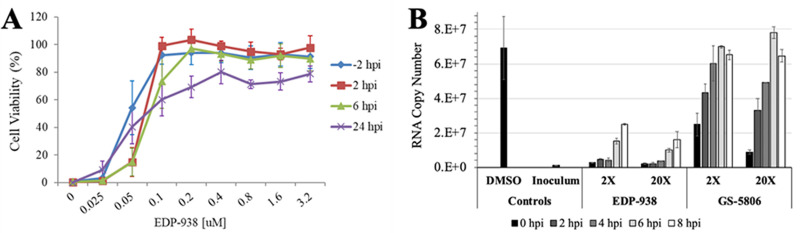
In vitro time-of-addition studies with EDP-938.(A) Cell viability of RSV-A Long-infected HEp-2 cells with EDP-938 treatment given at indicated times relative to infection. Cells were infected at an MOI of 0.1 and harvested 5 days post infection. All data are mean ± SD, N = 3–6 per time point. (B) Single-round RSV infection comparing EDP-938 and fusion inhibitor GS-5806 treated to untreated (DMSO) samples. A cold-synchronized infection was performed with virus at an MOI of 3. Viral RNA was quantitated by RT-qPCR at endpoint 24 hpi. 2x and 20x EC50 values are 100 nM and 1,000 nM for EDP-938, 2 nM and 20 nM for GS-5806. All data are mean ± SD, N = 2 per time point.